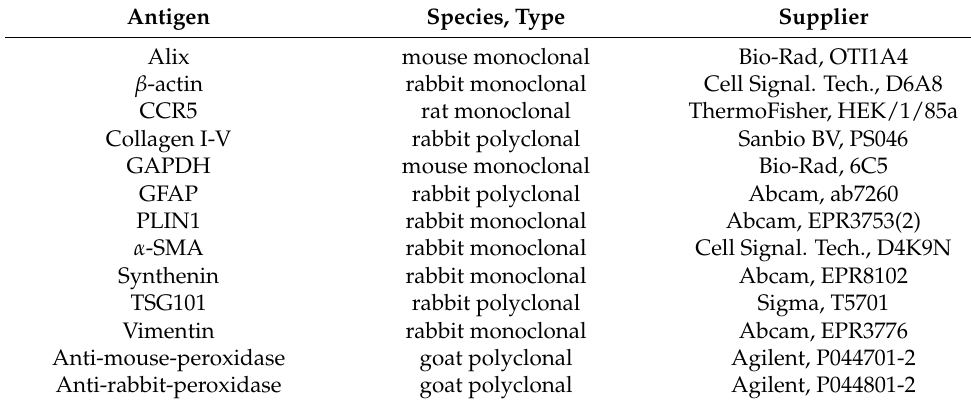
Table 1. Antibodies, species and supplier